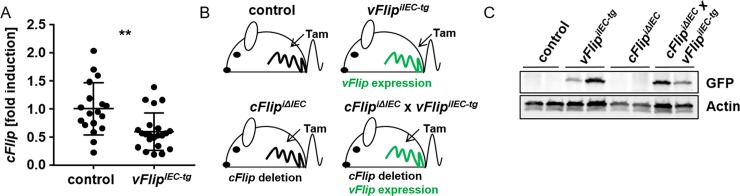
Analysis of vFLIP-regulated cFlip expression and generation of an inducible mouse model.(A) Gene expression analysis of cFlip in control and vFlipIEC-tg mice; n≥18. Fold induction values were calculated relative to controls, Hprt was used as a housekeeping gene. (B) Generation of mouse models to induce vFlip expression (linked to Gfp expression) and/ or to delete cFlip expression respectively in IECs of mice after at least 2 days of consecutive intraperitoneal tamoxifen injection. (C) Western Blot analysis of GFP in small intestinal lysates of indicated mice after 2 consecutive days of tamoxifen injection. Actin was used as a loading control.